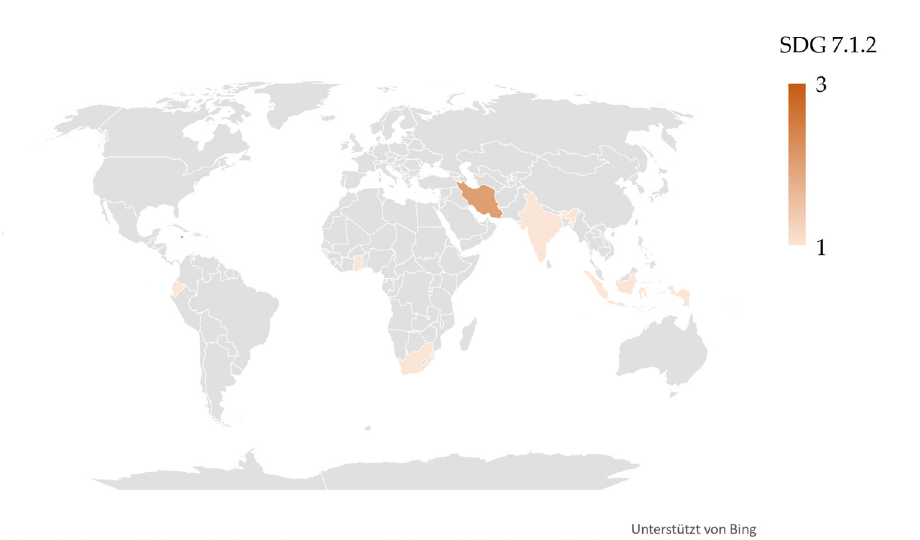
Figure A4. Geographic location of the case studies in ( a ) hydrogen in the rationale of SDG 7.1.1. Maximum = Iran (8), India (3), Cuba, Ecuador, Brazil, Ethiopia (2 respectively). Notably, three studies did not specify the country; and ( b ) hydrogen in the rationale of SDG 7.1.2. Maximum = Jamaica (3), Iran (2), others (1 respectively).